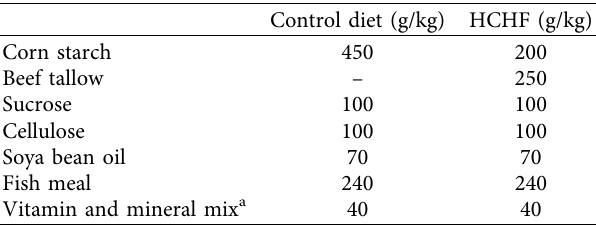
Table 1: Feed and diet composition. Control diet (g/kg) HCHF